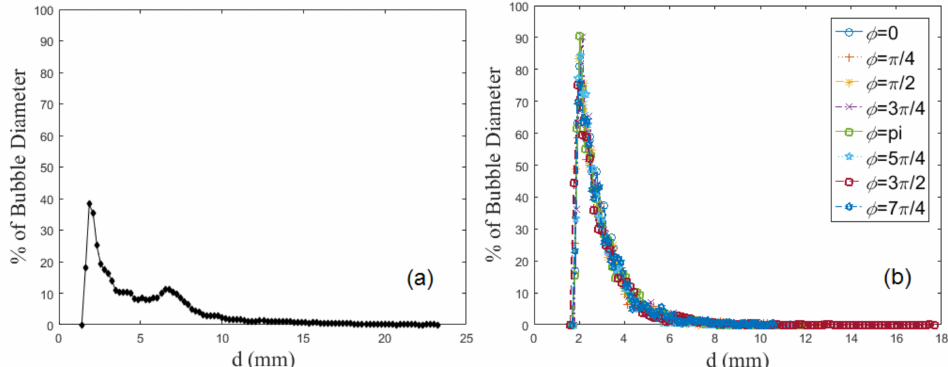
Figure 4. Probability density function of bubble sizes ( U SG = 27 mm/s, P 0 = 1 atm) for the ( a ) static column and ( b ) column vibrating at f = 10 Hz with A = 6 mm. Symbols for the vibration phase ( φ ) in radians is provided in the